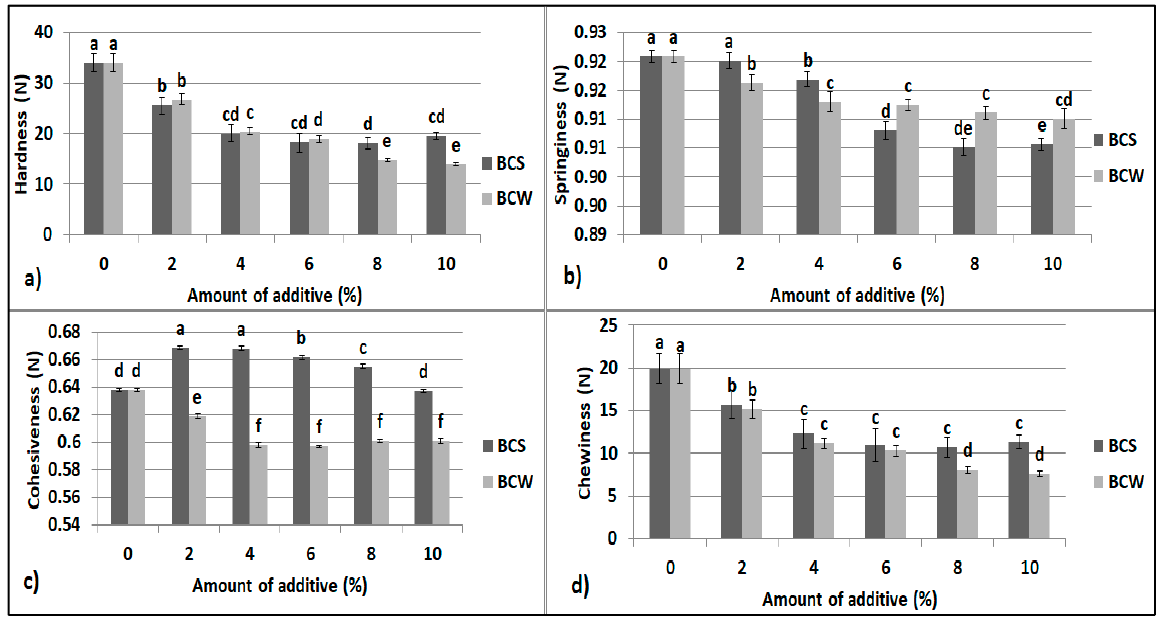
Figure 1. Textural properties of starch bread with BCS and BCW: ( a ) hardness, ( b ) springiness, ( c ) cohesiveness, ( d ) chewiness; mean values in the same figure marked with different letters are significantly different ( α = 0.05).